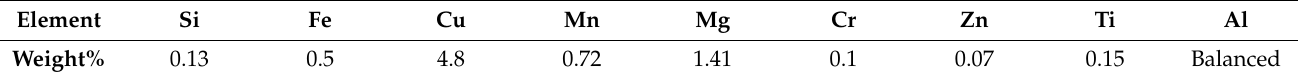
Table 1. Standard chemical composition of AA2024-T3 alloy.